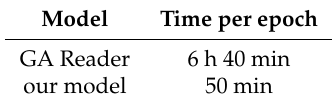
Table 3. The training time comparison between GA Reader model and our model on CliCR data set.